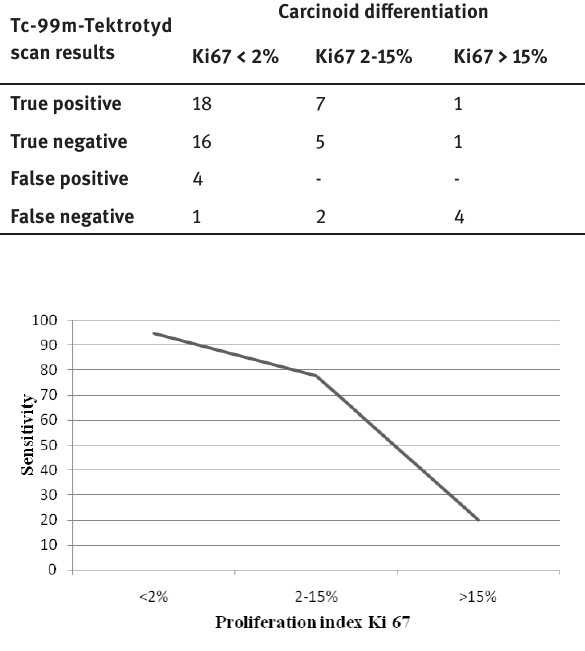
Figure 1: Sensitivity of Tc-99m-Tektrotyd scan in relation to proliferation index Ki67.